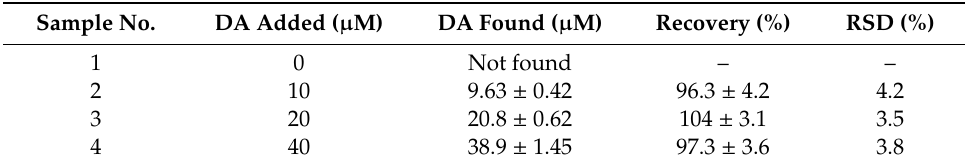
Table 2. Detection of DA in urine samples (n =